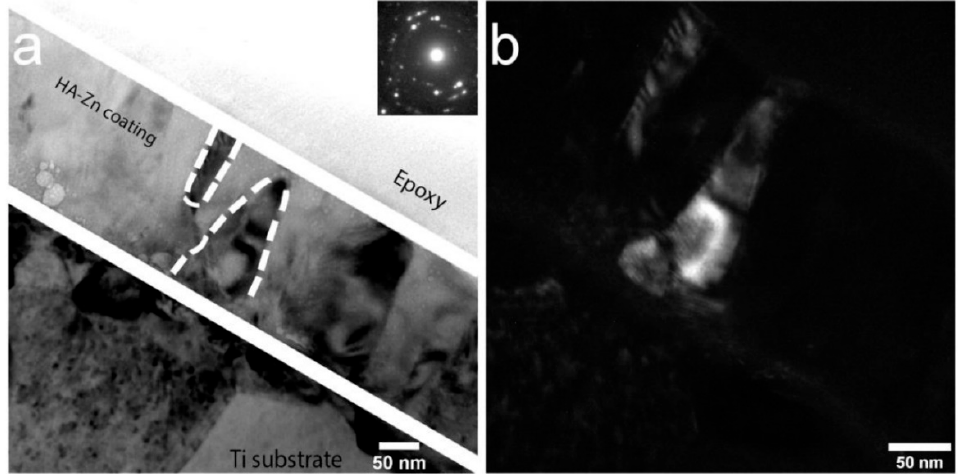
Figure 17. TEM image of the cross-section of Zn-HA coating on Ti deposited at the substrate temperature of 400 °C bright field, the inset shows the corresponding SAED ( a ) and dark field ( b ) [62]